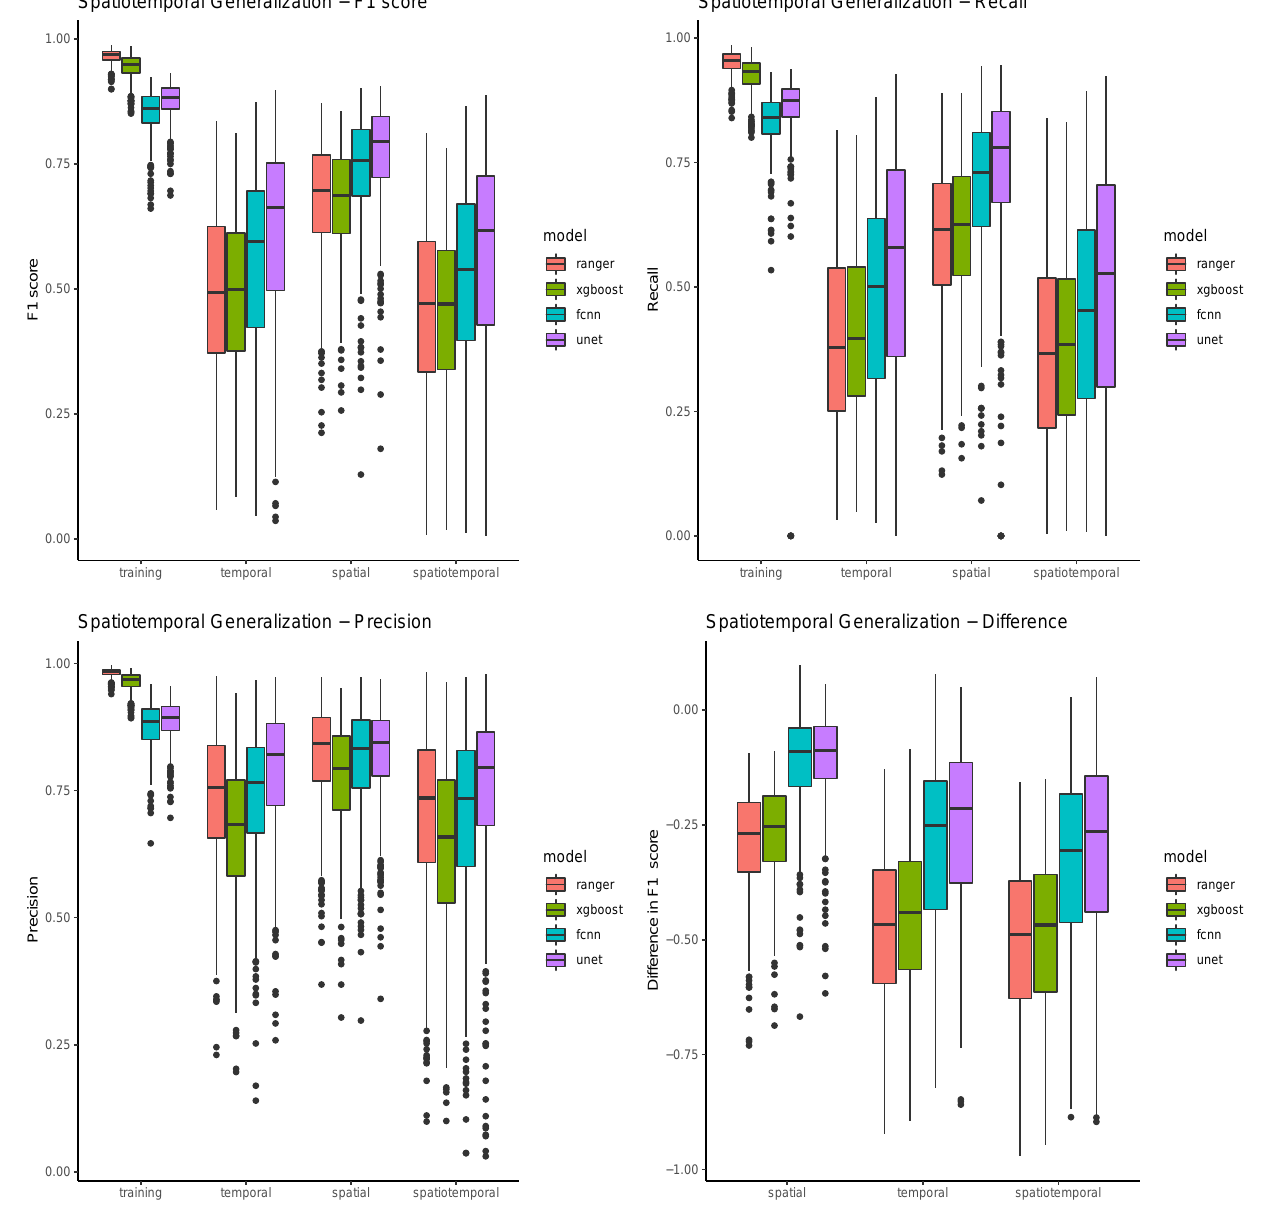
Figure 9. The figure shows boxplots for all three performance metrics plus the performance difference between scopes. Boxplots are grouped by scope and colored by